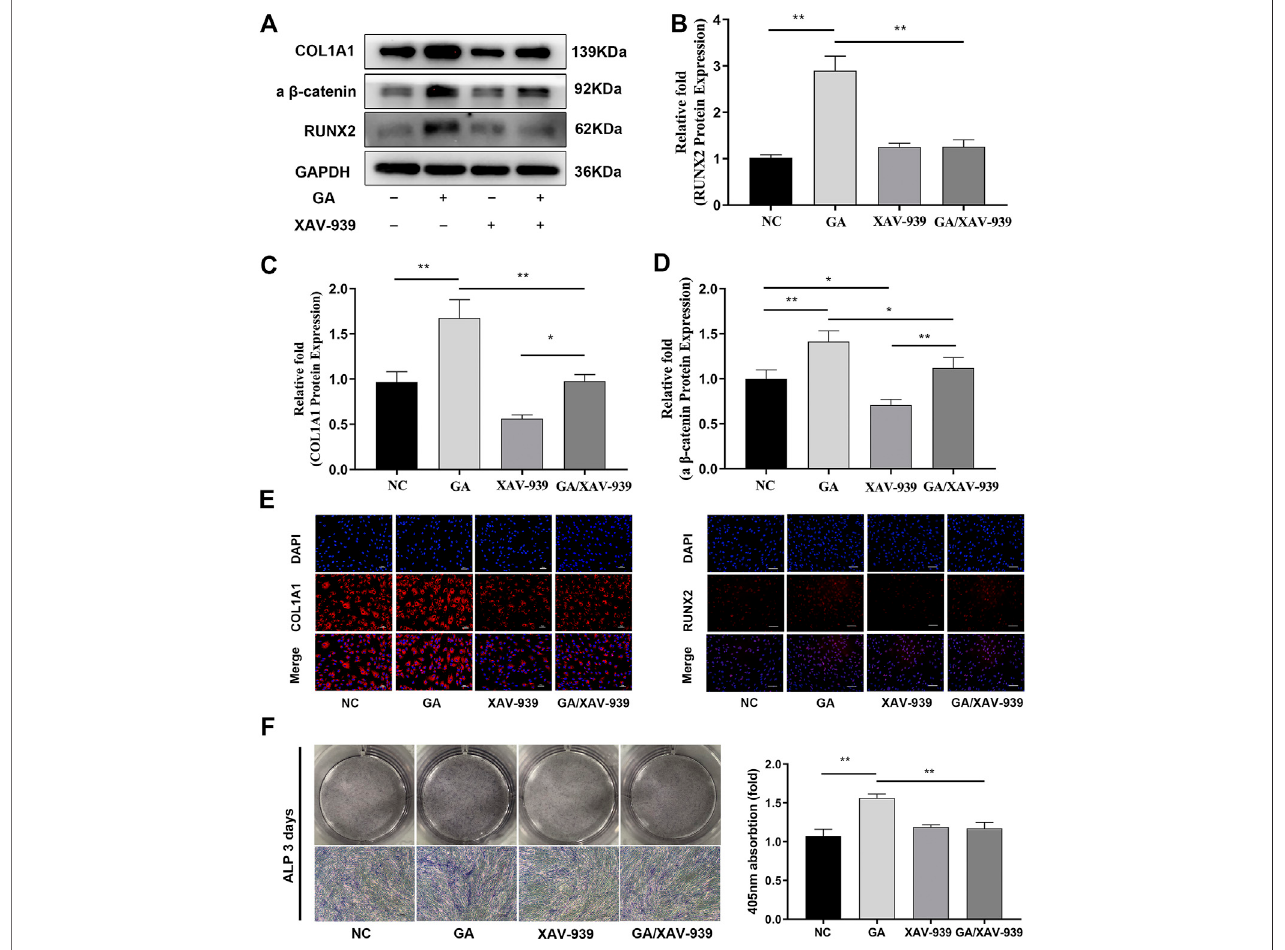
FIGURE4| Enhanced osteogenicdifferentiationofhMSCsduetoGAwaspartiallyattenuated bytheaddition ofWnt/cateninsignalinginhibitor. (A) Inhibition ofthe Wnt/catenin signaling pathway partially attenuated the increases in RUNX2 and COL1A1 protein expression levels after addition of XAV-939 for 3 days. The protein expression levels were normalized relative to that of GAPDH protein. (B – D) Relative quantitative analysis of the western blotting results for active β -catenin, RUNX2 and COL1A1 protein. (E) Immuno fl uorescence staining after 3 days of osteogenesis. Scale bars, 100 μ m. (F) ALP staining revealed decreased ALP activity in the GA/ XAV-939 group compared to the GA group. Scale bar, 500 μ m. Data are expressed as means ± SD. * p < 0.05 and ** p < 0.01 between the two groups.